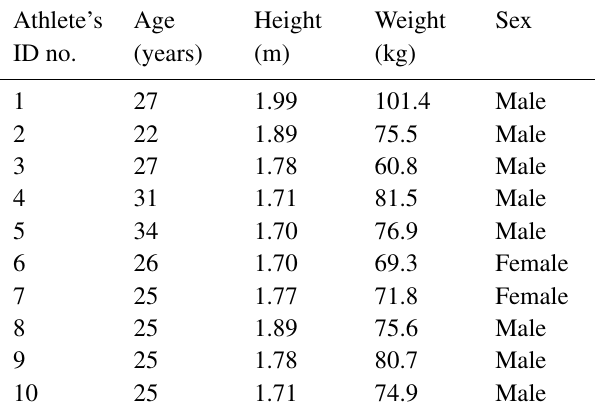
Fig.3: Simulated dehydration of the legs were assessed by measurements with the Xitron Hydra on ad- ditional athletes (not the validation group for the simulation) and for all athletes the MM was calculated before and after exercise according to equation 7 to determine the change of muscle tissue conductivity ( 0 . 045 S / m ). The results of the ≈ simulations are shown in figure 3.